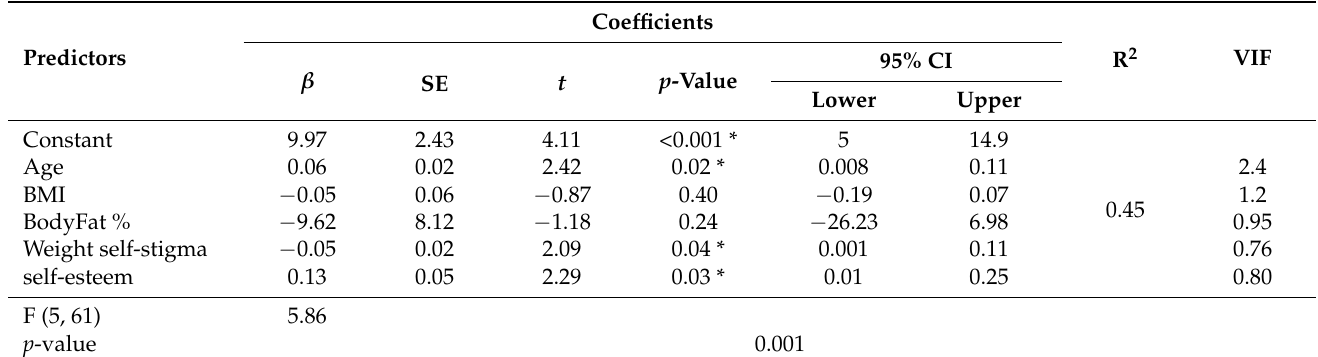
Table 3. Multiple linear regression analyses to examine the independent associations between peak oxygen uptake and weight self-stigma and